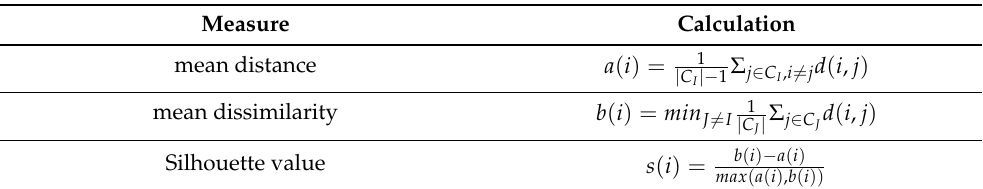
Table 3. Silhouette scoring functions. Let C I be the cluster which node i belongs to.